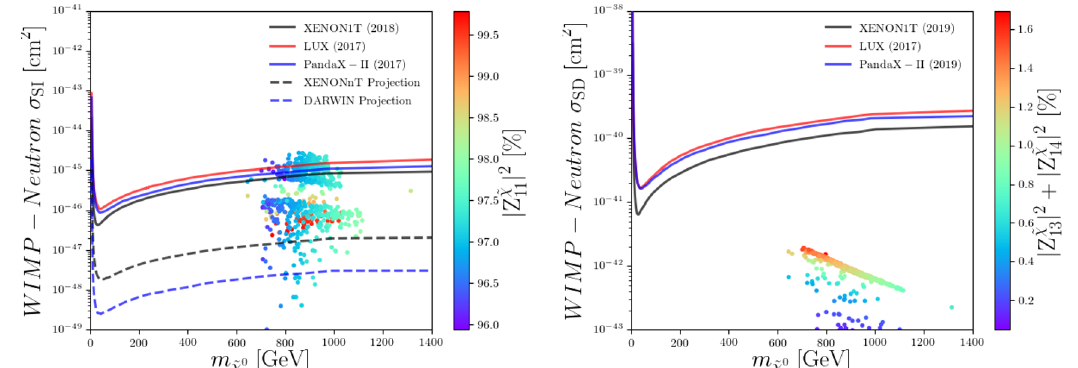
Figure 6 . DM-neutron SI (left) and SD (right) scattering cross section as a function of the mass of the lightest neutralino LSP. The colour bars show the composition of the LSP. Limits from current (solid) and future (dashed) experiments are also